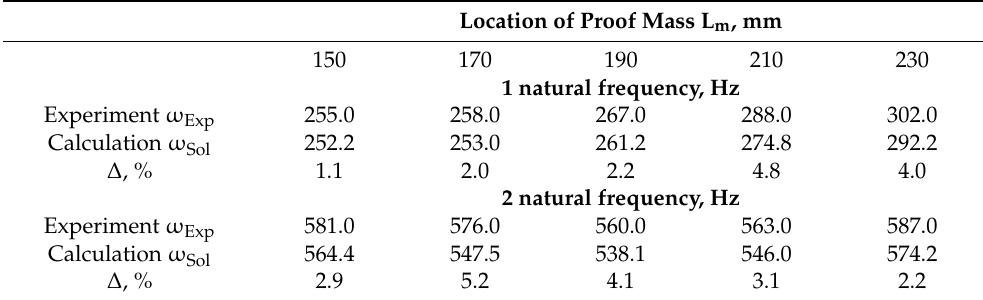
Table 6. Comparison of the experimental and numerical values 1 and 2 of the natural frequencies of PEG oscillations at an active load of PE of 10 k Ω and a load value of 3.71 g at different